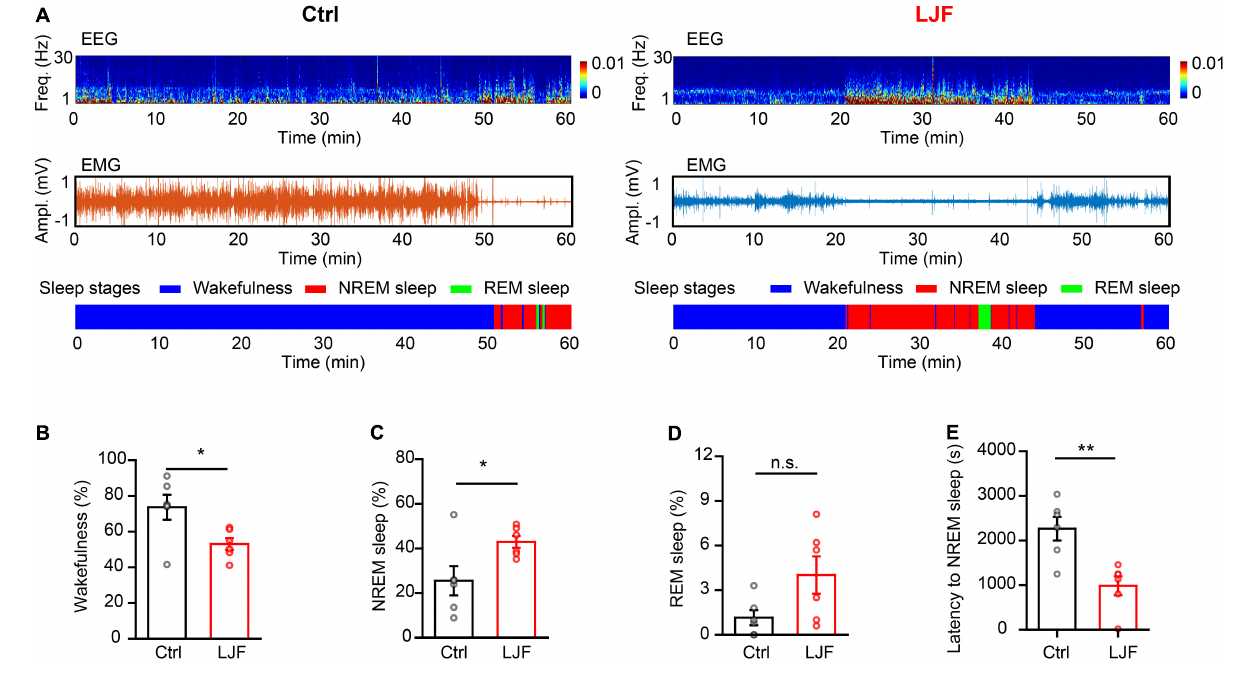
FIGURE 4 | Lonicerae Japonicae Flos (LJF) promotes sleep recovery after acute sleep deprivation. (A) The representative spectrograms display interchange of brain states in the first hour after sleep deprivation between the control (left) and LJF-treated (right) mice. (B–E) Time spent by the control and LJF-treated mice in (B) wakefulness, (C) NREM sleep, (D) REM sleep, and (E) latency to NREM sleep after acute sleep deprivation in the first hour. n = 6 per group; The data are expressed as mean ± S.E.M; two-tailed unpaired t -test was used for comparing data; ** P < 0.01, * P < 0.05. n.s., no